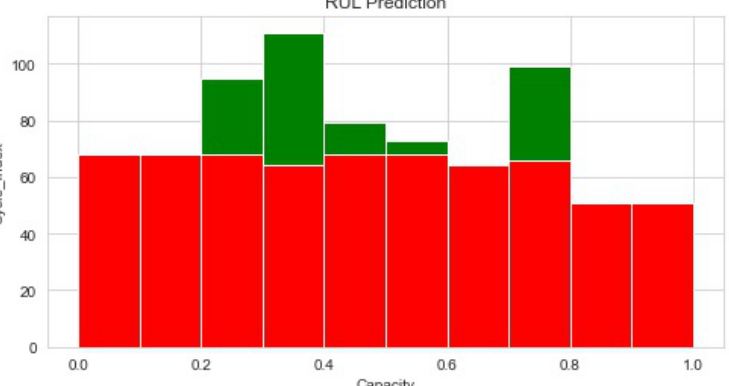
Figure 9. The normalized histogram capacity and the cycle of RUL